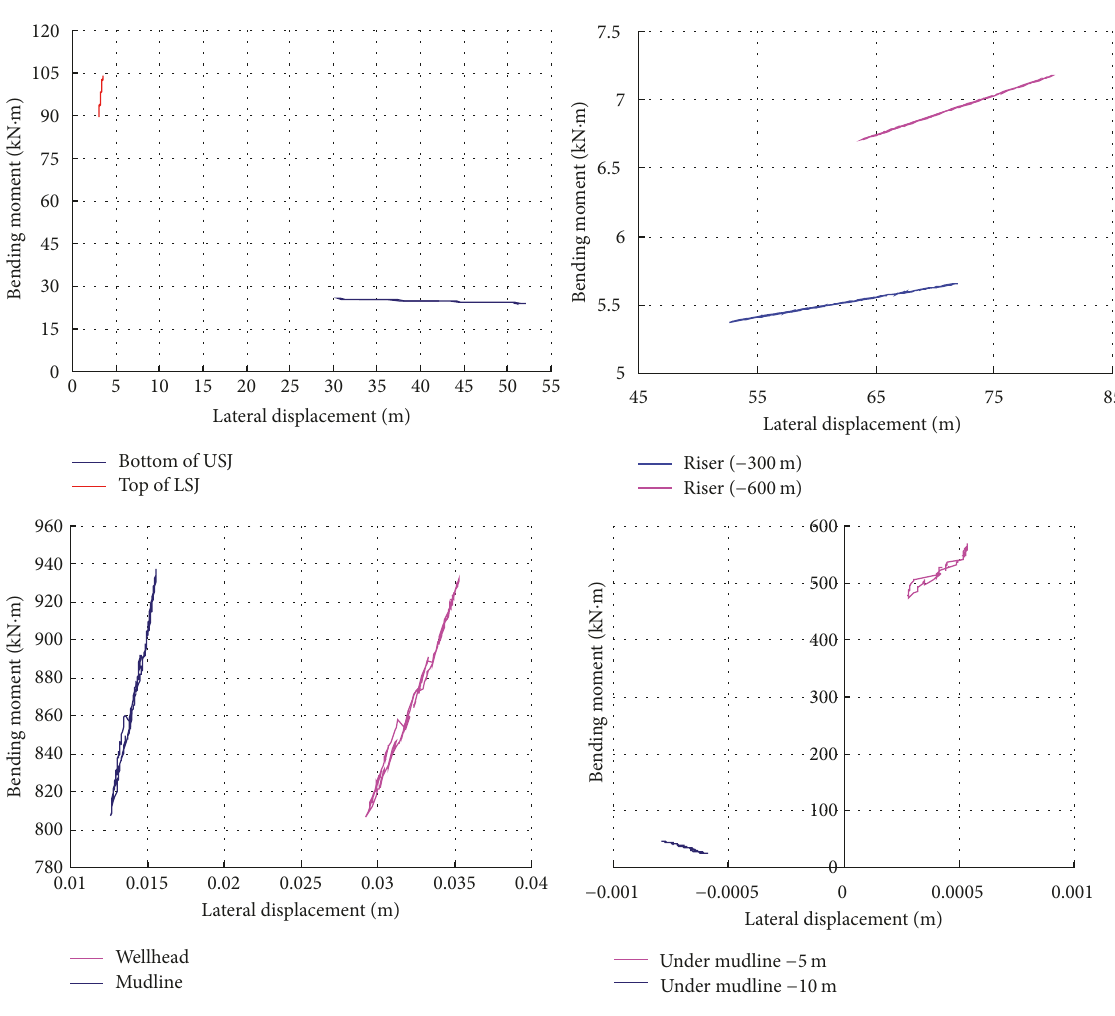
Figure 9: Moment-displacement